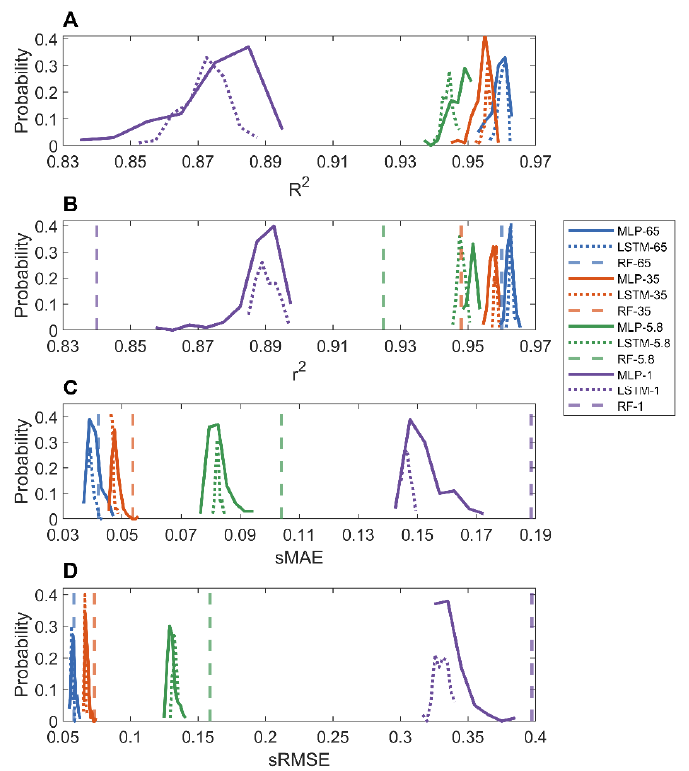
Figure 2. Distributions of R 2 ( A ); r 2 ( B ); sMAE ( C ); and sRMSE ( D ) from holdout validations. Results of MLP, LSTM, and random forest models were plotted in solid, dotted, and dashed lines, respectively. Predictions of methane adsorption pressures were color coded as purple for 1, green for 5.8, red for 35, and blue for 65 bar.